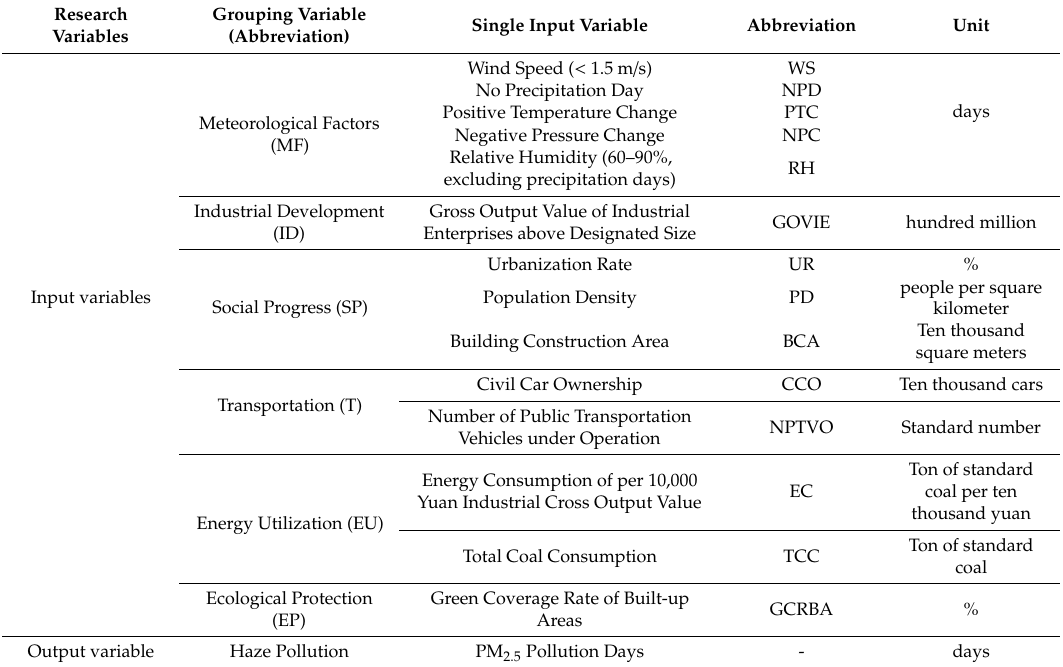
Table 2. Research